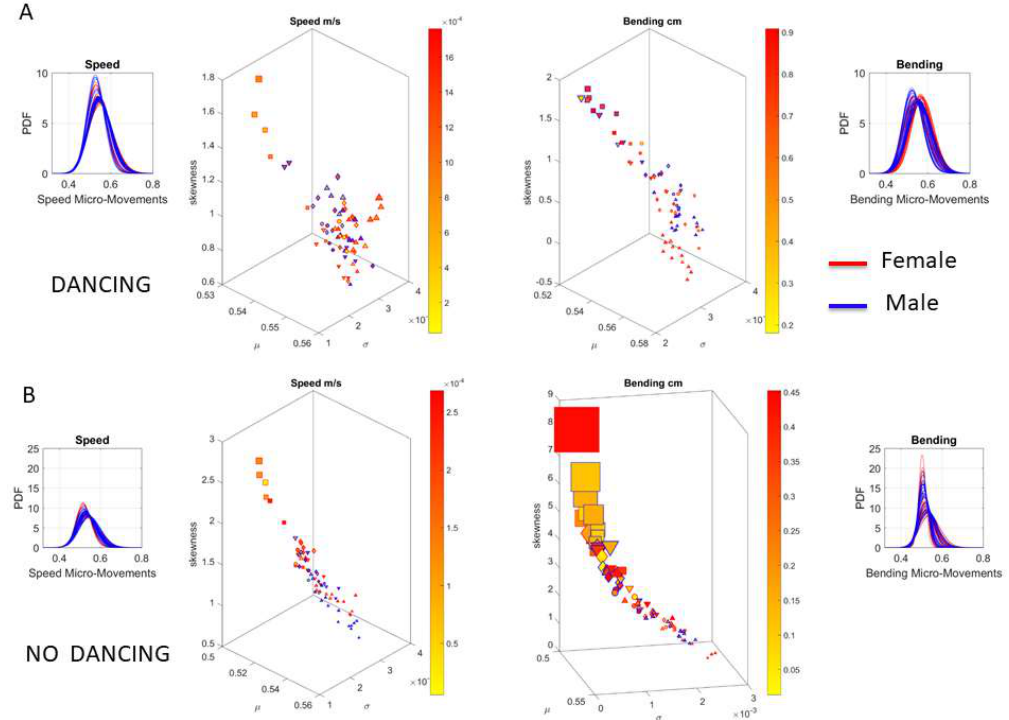
Figure 14. Summary statistics for the empirically estimated continuous family of Gamma probability distributions for speed and bending profiles taken for each of the 76 body nodes for the female and for the male dancer, by pooling movement activity across the 14 dancing routines ( A ) and non-dancing (calibration and planning) segments ( B ). Color bars represent physical levels of fluctuations in linear speed (cm/s) and bending (cm) measured as departures from the overall estimated Gamma means. Axes are as explained in methods ( x -axis Gamma mean, y -axis Gamma variance, z -axis skewness and kurtosis represented in the size of the marker; squares represent lower body, triangles upper body, and circles head LEDs; blue edges represent male and red edges female).